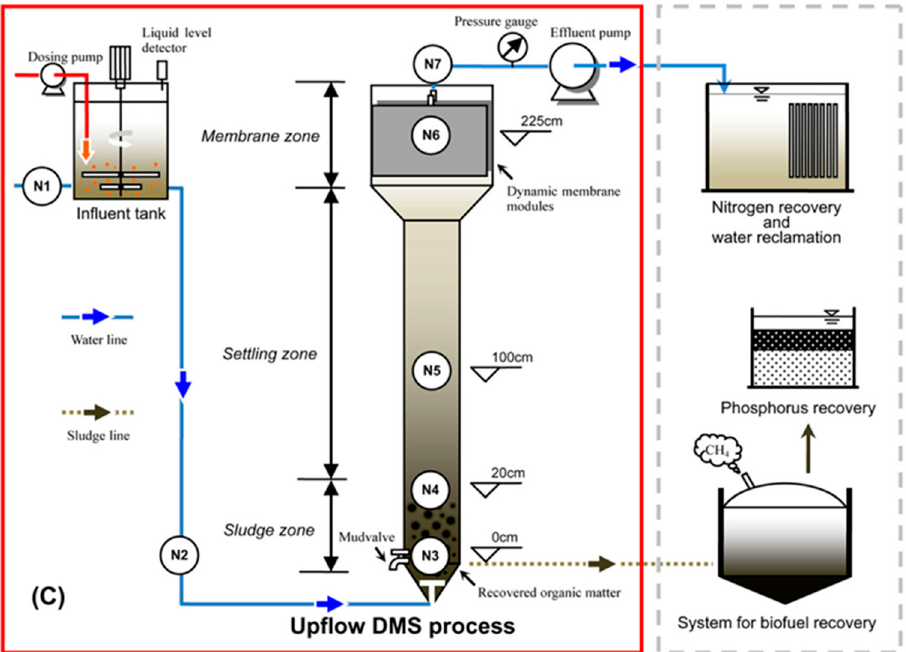
Figure 6. Schematic illustration of the upflow DMS process [72] (reprinted with copyright permission).